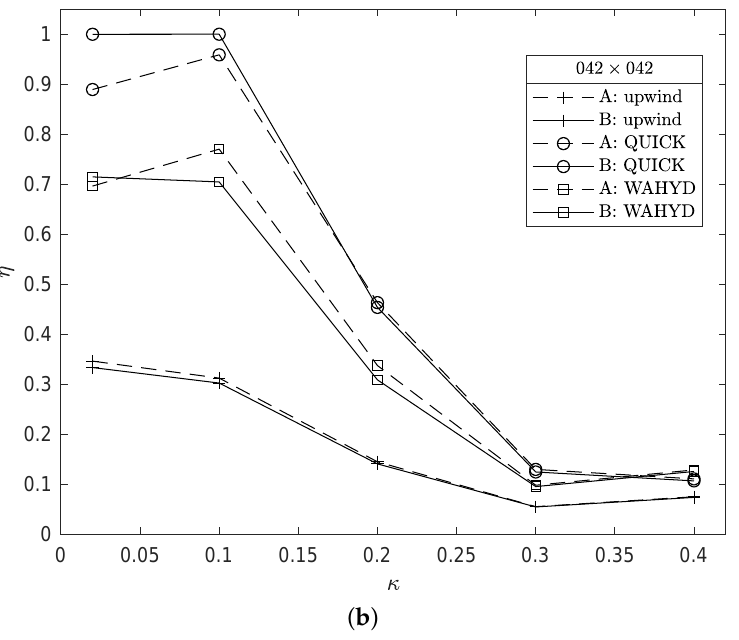
Figure 15. Computational efficiency as function of κ for the flow between concentric cylinders case and grids: ( a ) 22 × 22, ( b ) 42 × 42.